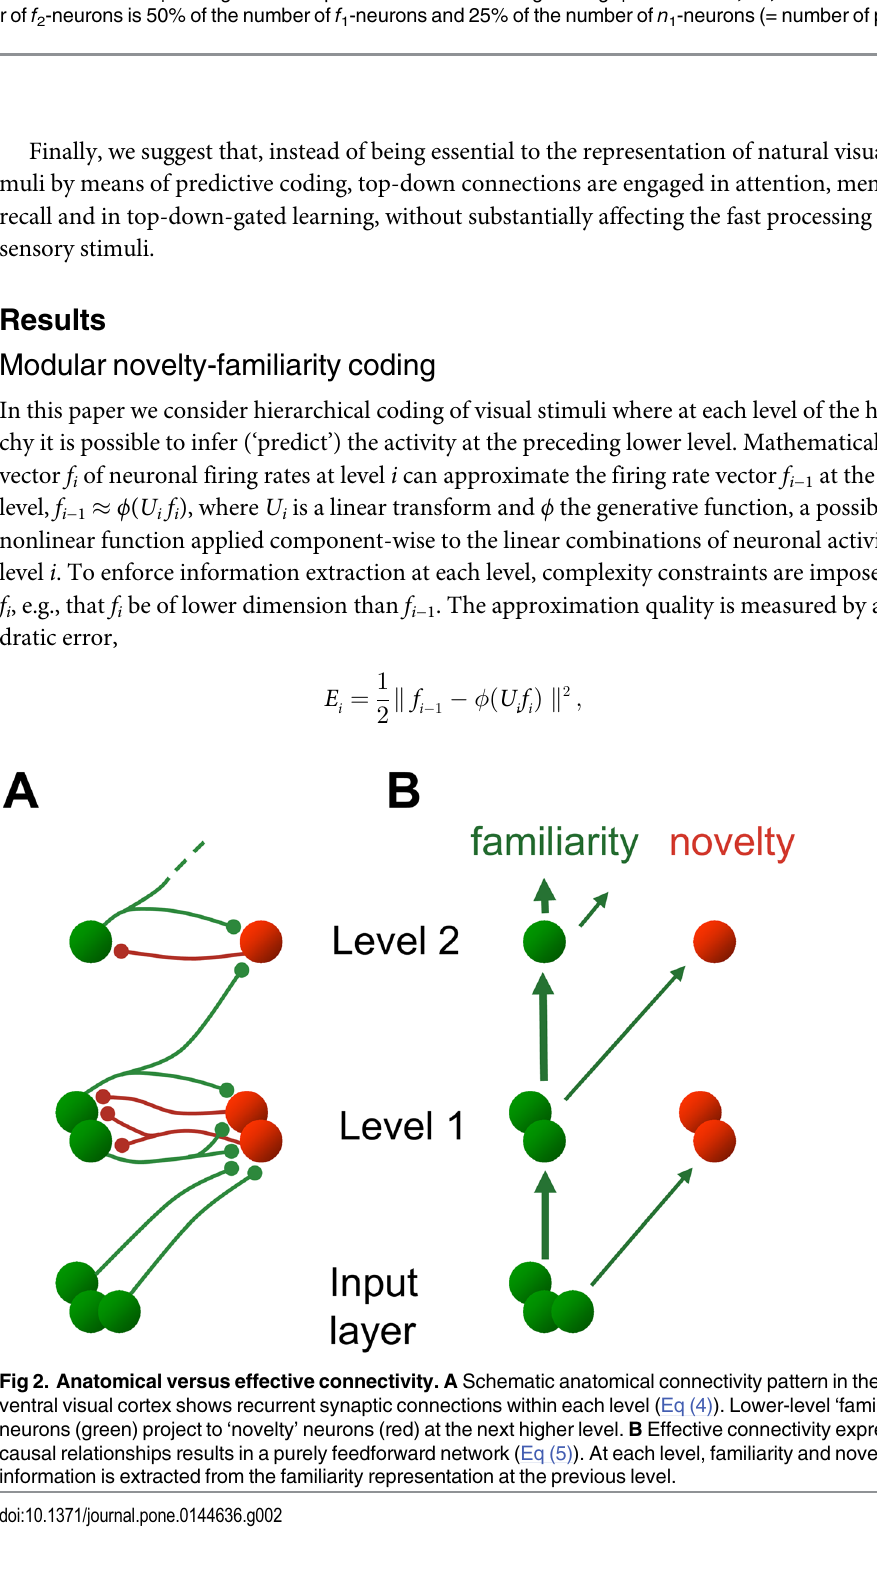
neurons f 1 receiving 1-to-1 input from n 1 -neurons through constrained connection matrix V 1 ( (cid:1) U T 1 ). d1 Reconstruction of the preprocessed image based on the steady-state activity of the level-1 familiarity neurons, f 0 (cid:1) U 1 f 1 . e1 Activity of level-1 novelty neurons n 1 receiving 1-to-1 input from the LGN and localized input from f 1 -neurons through the constrained connection matrix U 1 . Orange circles represent RFs of three neighboring f 1 -neurons. c2, d2, e2 The corresponding quantities for level 2. The number of f 2 -neurons is 50% of the number of f 1 -neurons and 25% of the number of n 1 -neurons (= number of pixels in the visual input).